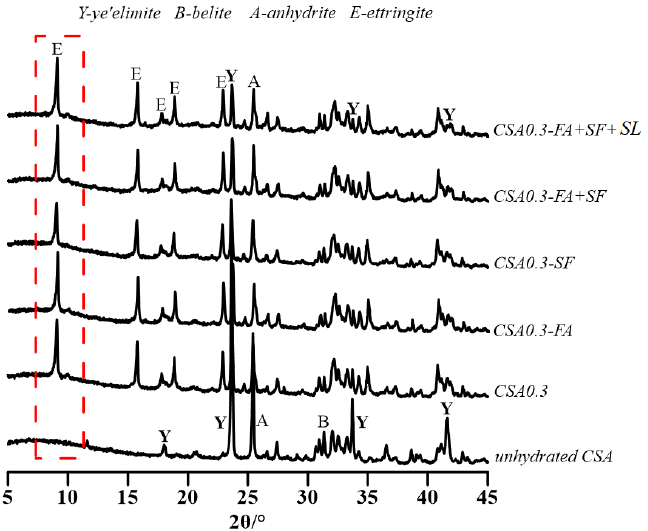
Figure 4. XRD results of calcium sulfoaluminate cement (CSA) paste with SCMs at 3 days.